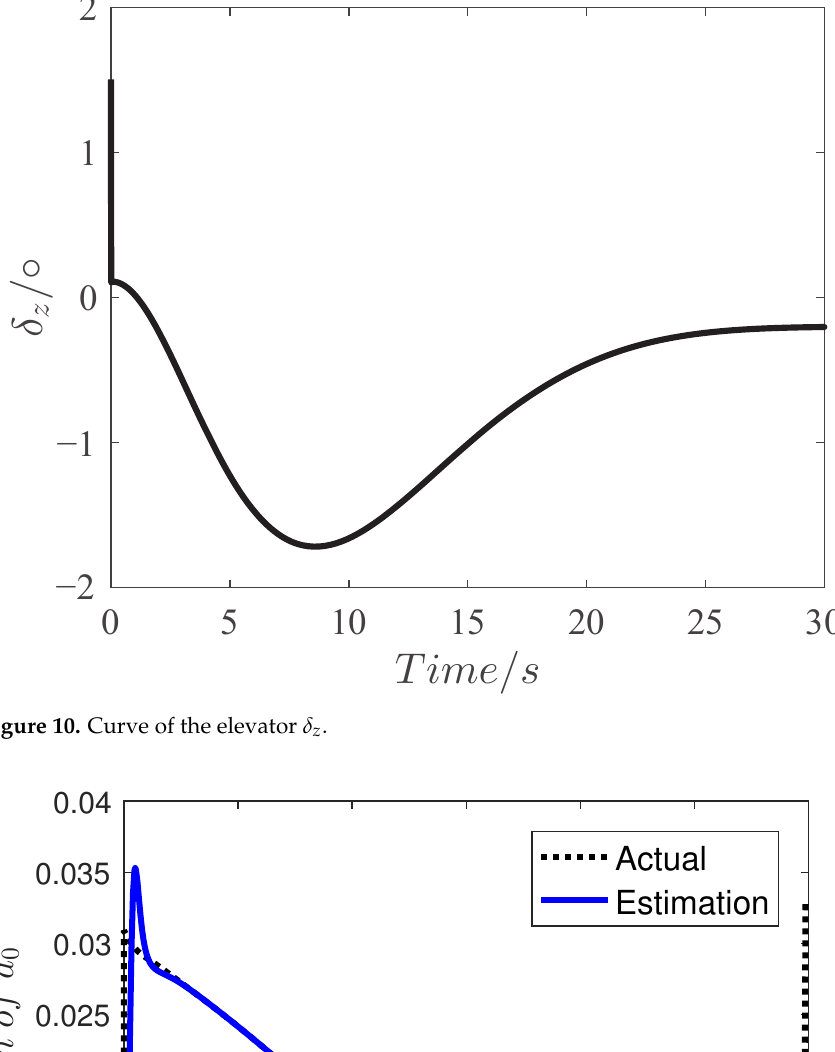
Figure 10. Curve of the elevator δ z .